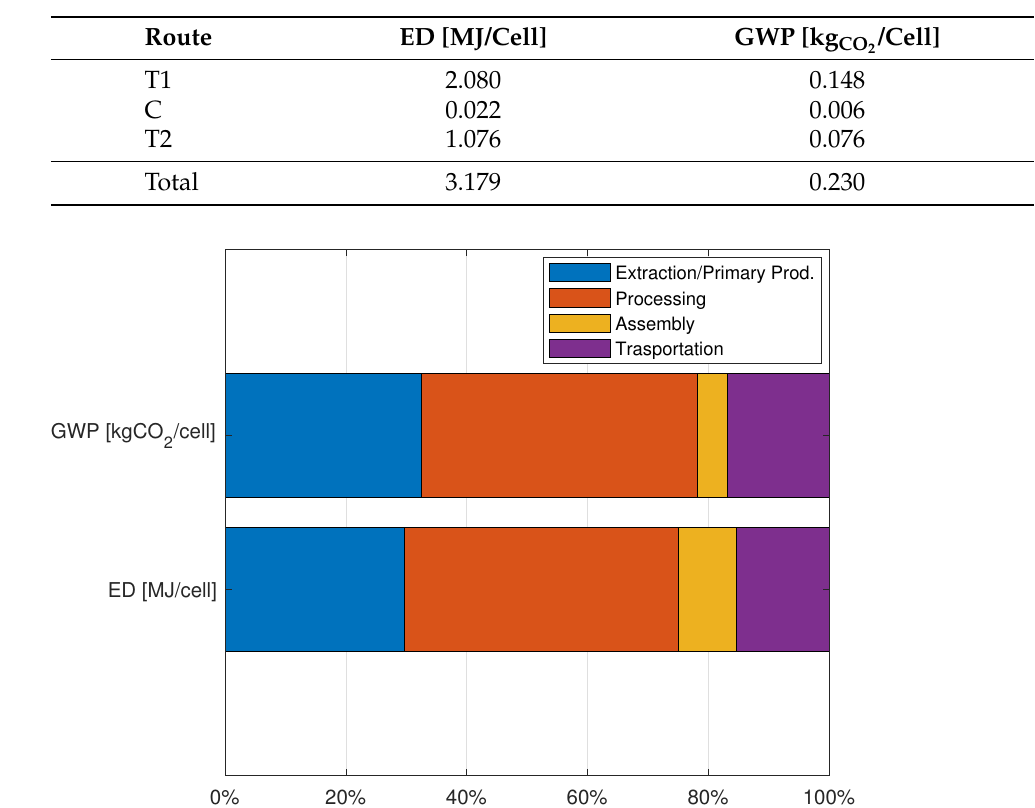
Table 7. Average ED and GWP related to the transportation of the cells considering all the travelled stages.